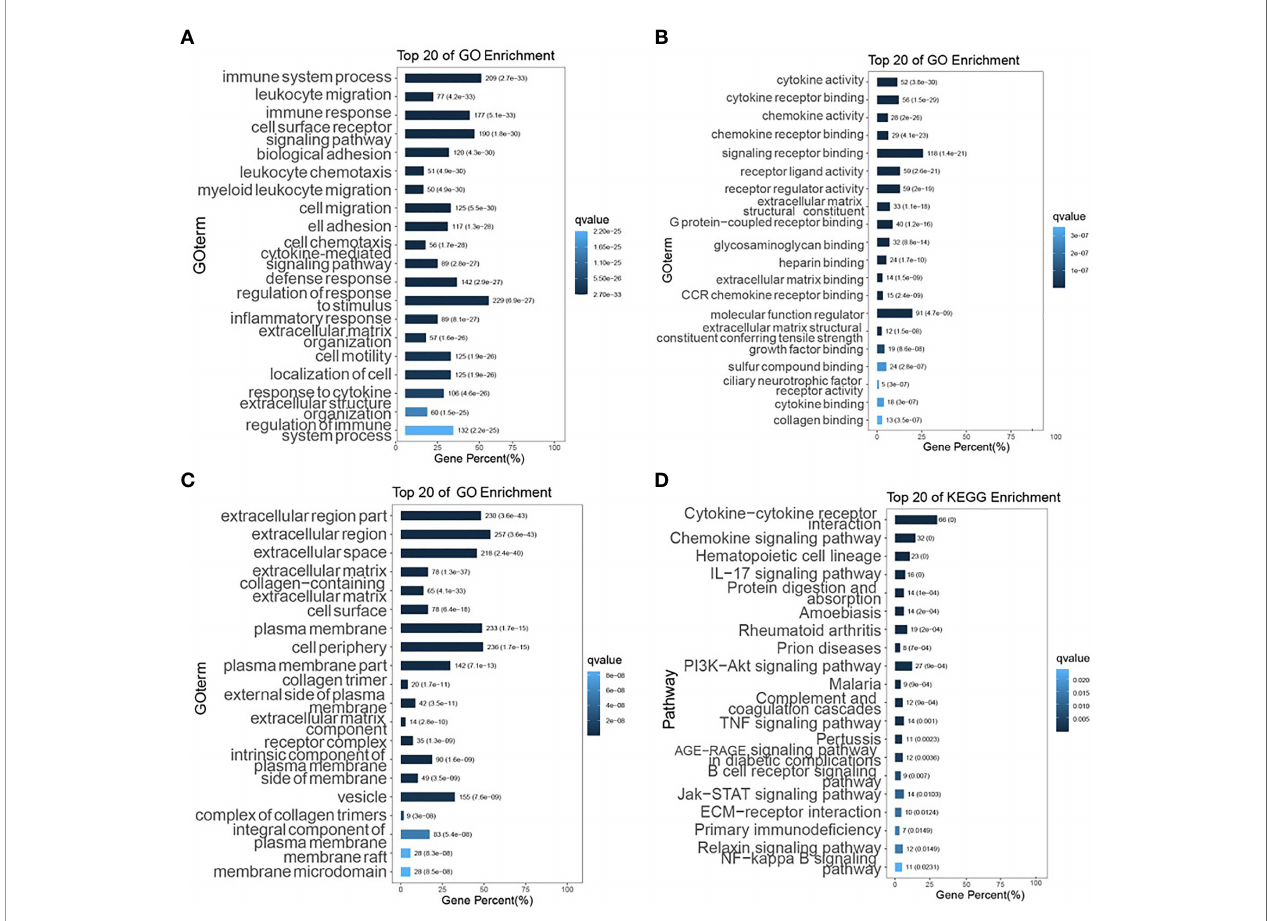
FIGURE 2 | GO function enrichment and KEGG pathway analysis. (A – C) The top 20 biological processes, molecular functions, and cellular components of GO terms, respectively; (D) The top 20 KEGG pathways.